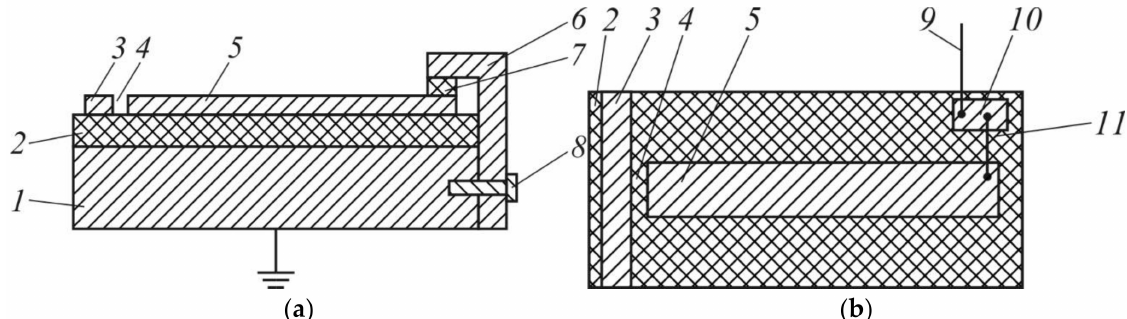
Figure 9. The structure of the measuring microstrip cell: ( a ) side view; ( b ) top view, without clamp and test specimen. 1, metal electrode; 2, dielectric polycor substrate; 3, microstrip line; 4, capacitive gap; 5, half-wave microstrip resonator; 6, clamp; 7, test sample; 8, screw; 9, conductor; 10, contact pad; 11, conductor that is an inductive element.